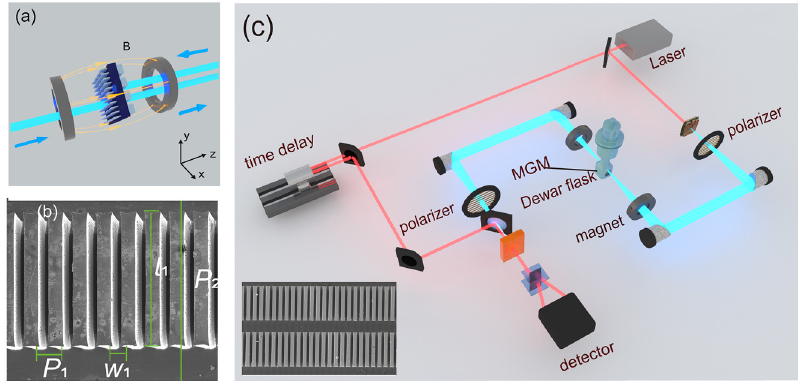
Figure 2: (a) The illustration of the transmissionprocess for the designed GIG. (b) The SEM image of the Si meta-grating structure on the surface of the InSb sub- strate. The parameters of the structure are as follows: the transverse